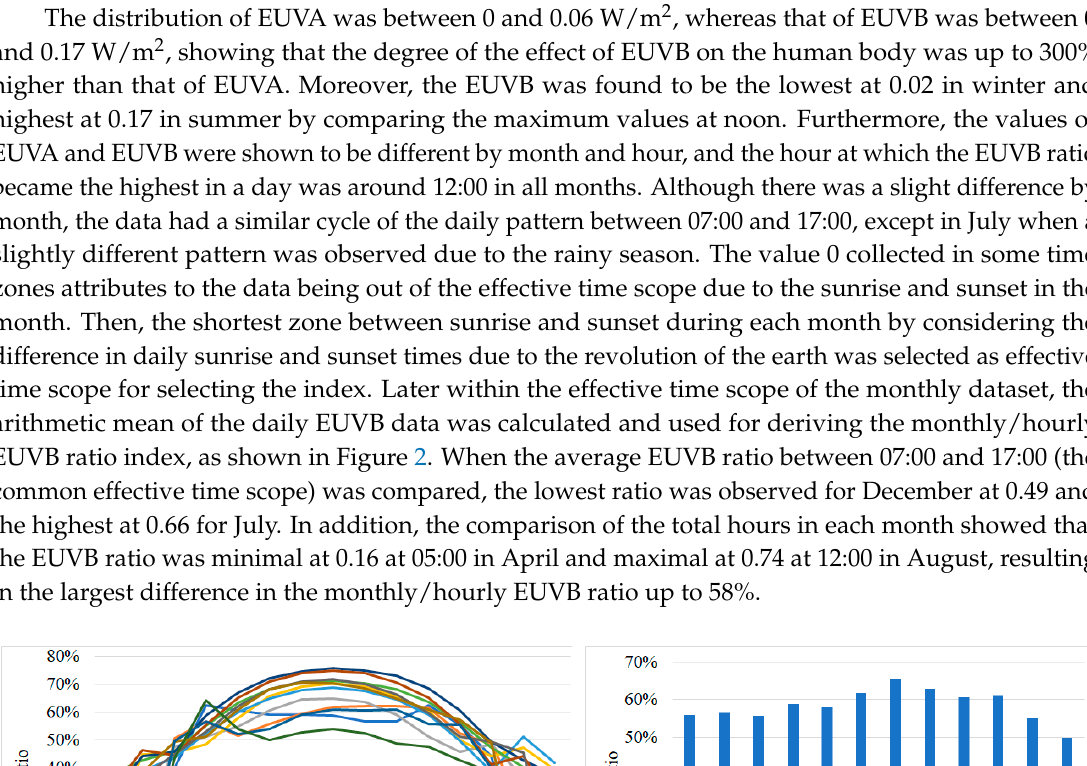
Figure 1. Current condition of the monthly erythemally weighted UV radiation (EUV) daily cycle (2017–2018; Cheonan, Chungcheongnam-do).